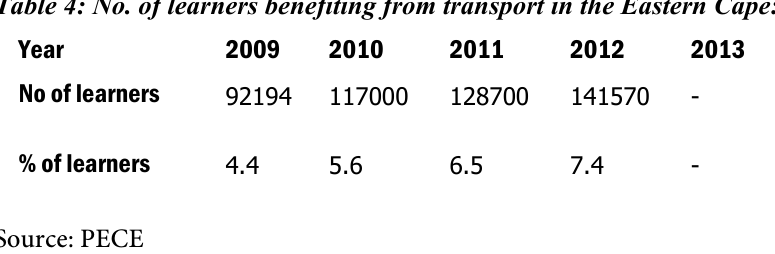
Table 4: No. of learners benefiting from transport in the Eastern Cape: